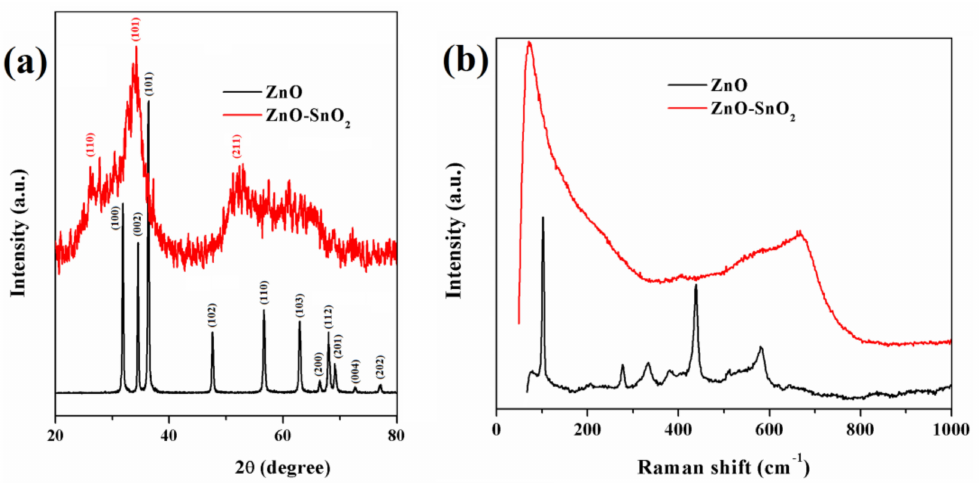
Figure 2. X-ray di ff raction patterns ( a ) and Raman spectra ( b ) of ZnO and ZnO-SnO 2 powders.